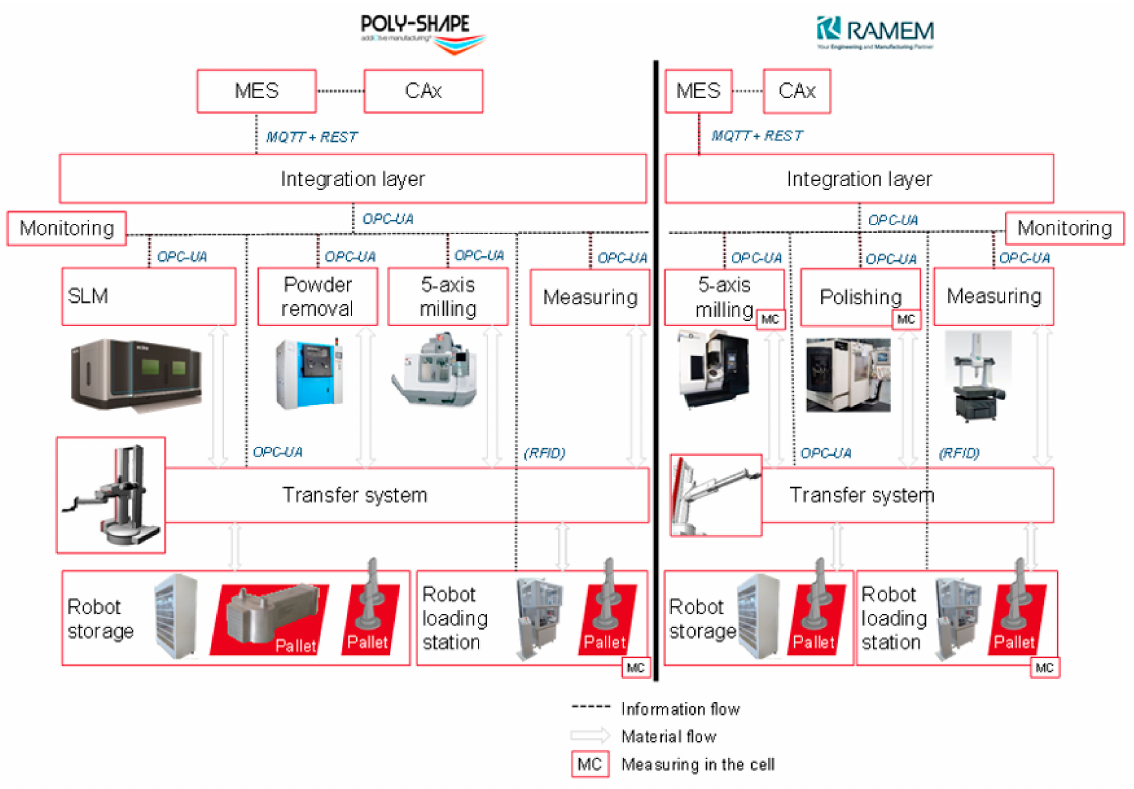
Figure 5. Layout and information of material flow of the SLM production cells [11]. Copyright 2018/2019 SmartFactory-KL (collaborative